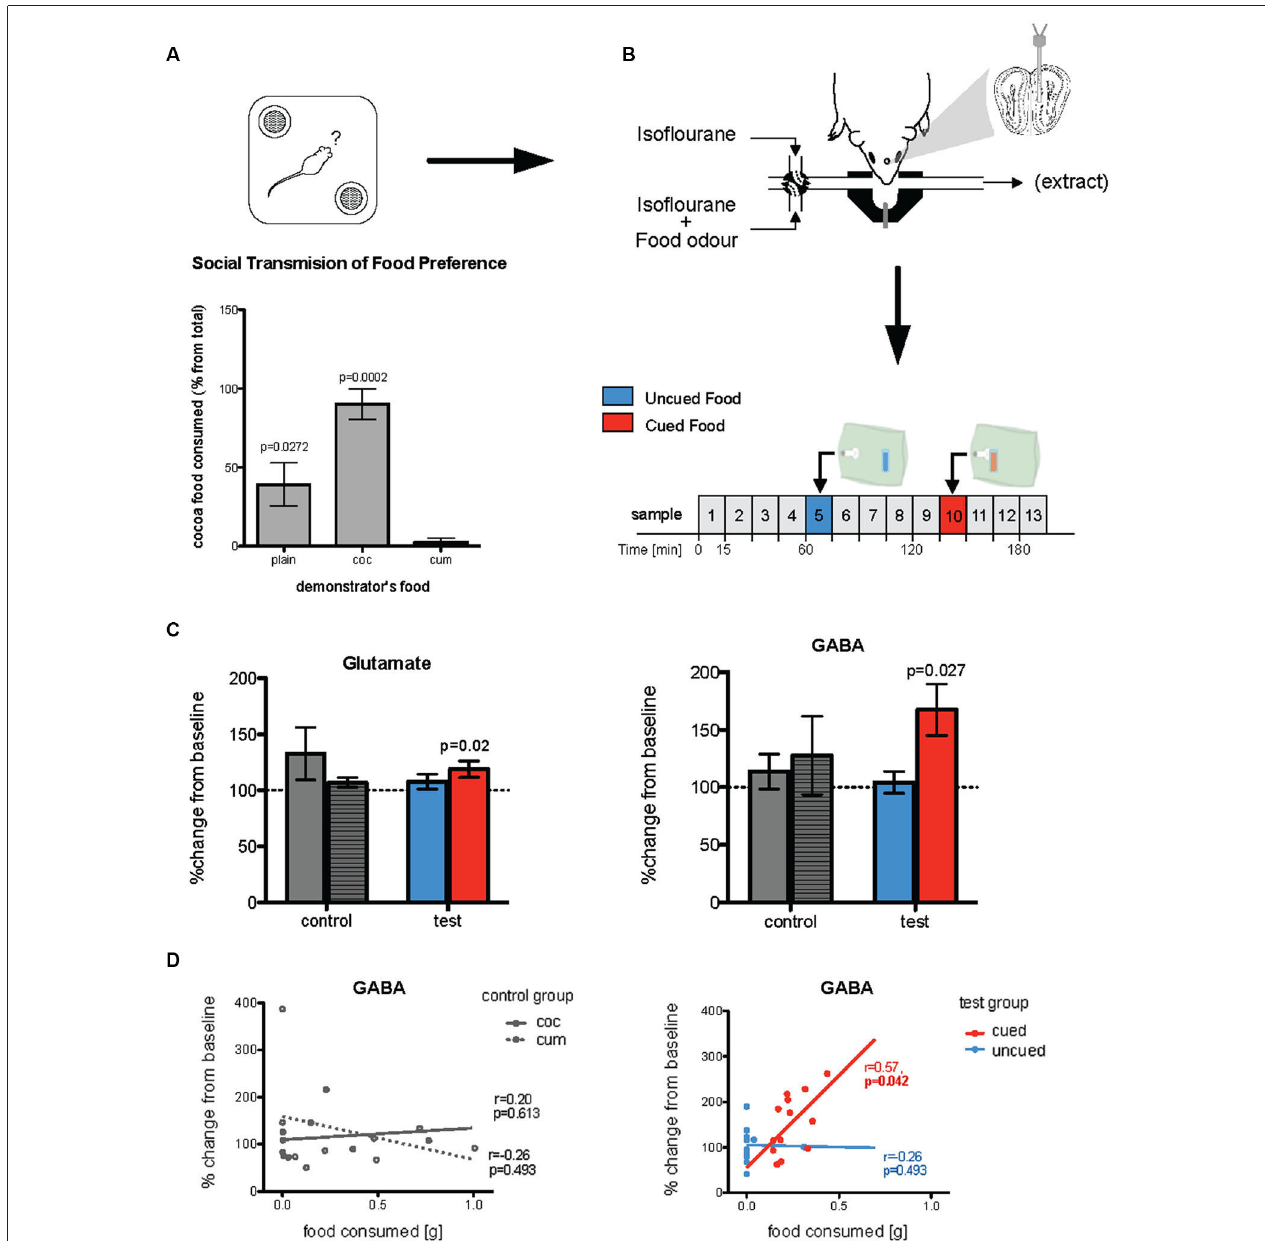
FIGURE 2 | Changes in in vivo glutamate and GABA following olfactory learning . (A) Food preference test of observer mice where they were given a choice between cocoa- or cumin-scented foods, 24 h after exposure to the demonstrator’s breath when both observer and demonstrator were anesthetized (Training procedure 1). Histograms show relative consumption of cocoa-scented food (% from total intake). Relative consumption of the two foods was significantly different across the groups ( p = 0.0007). While plain food-trained mice (controls, whose demonstrator had been given normal plain food) showed no significant preference for either food, cocoa-trained mice ate almost exclusively cocoa-scented food and cumin-trained animals ate nearly none ( p -values given in the Figure are relative to cumin-trained mice). (B) Immediately after being tested for food preference, mice were used for microdialysis experiment.